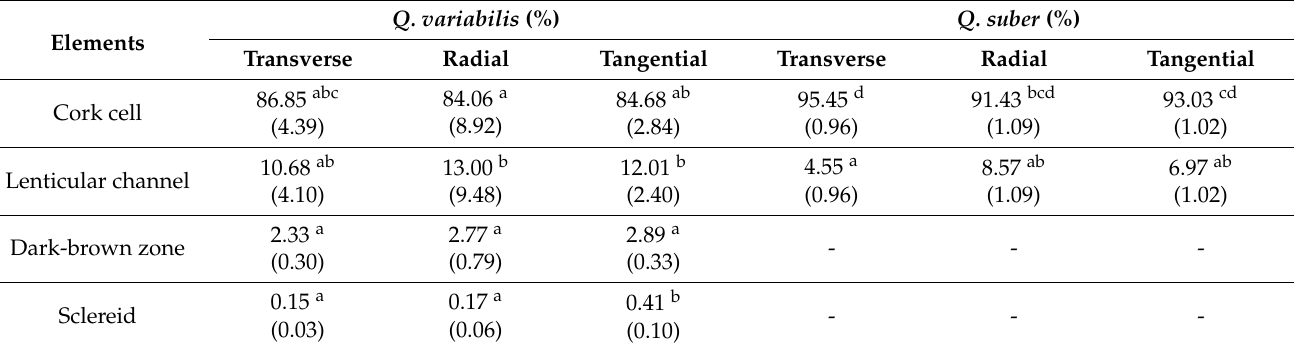
Table 4. Cork tissue percentages in Q. variabilis virgin cork and Q. suber reproduction cork. Table 4. Element composition in Q. variabilis virgin cork and Q. suber reproduction cork. Elements